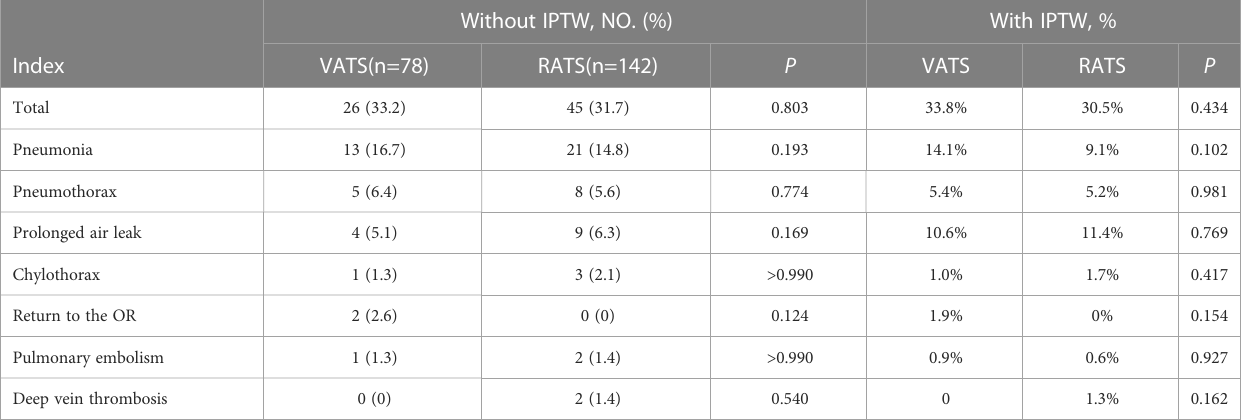
TABLE 5 Unadjusted and IPTW adjusted postoperative